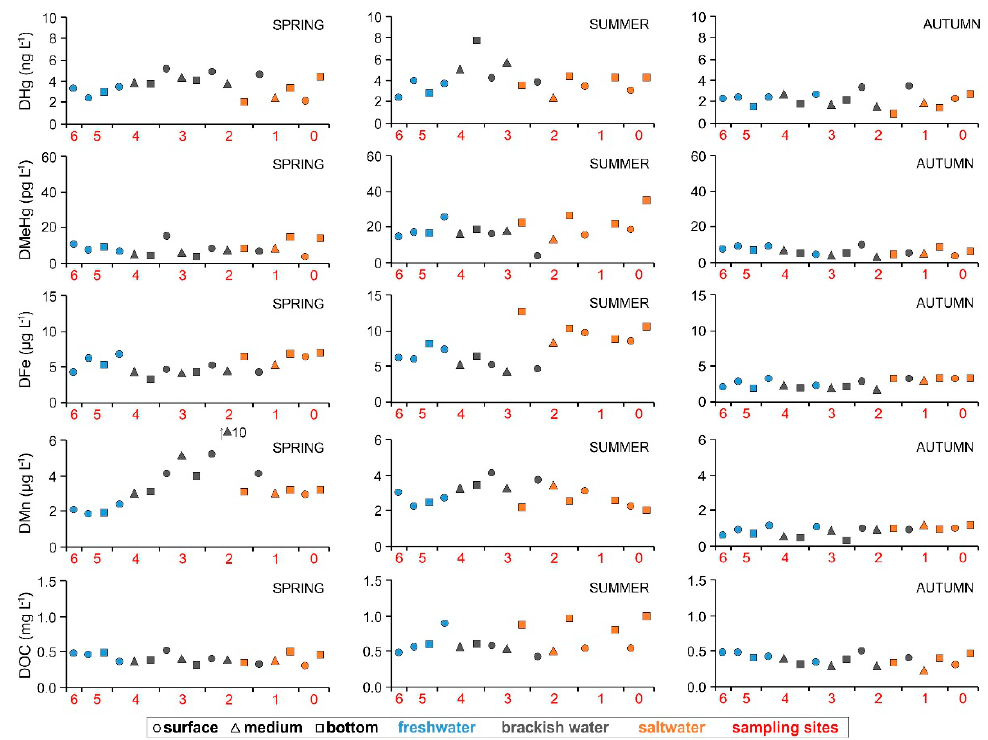
Figure 4. Distribution of DHg, DMeHg, DFe, DMn and DOC in the water column from the upper sector of the estuary of the Nalón River to its mouth (from site 6 to site 0) under different seasonal conditions (spring, summer and autumn).